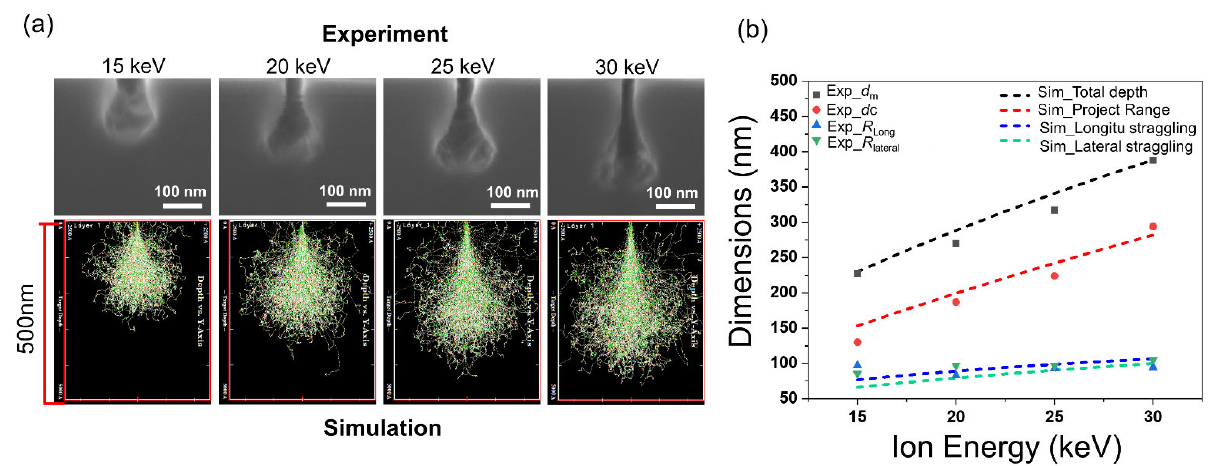
Figure 2. ( a ) Experimental(upper row) and simulation(lower row) results of Si nanostructures fabricated by HIBEE with different acceleration voltages of helium ions of 15, 20, 25, and 30 keV. ( b ) The experimental and simulation dimensions of the ion dispersion range with different ion energies, both indicating that higher ion energy leads to deeper channels and larger lateral straggling.